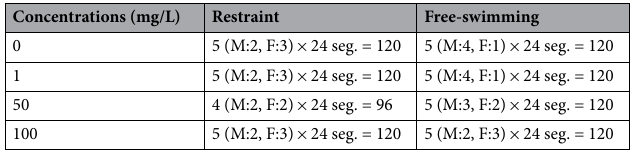
Table 4. Number of individuals. seg., segments; M, male; F, female.